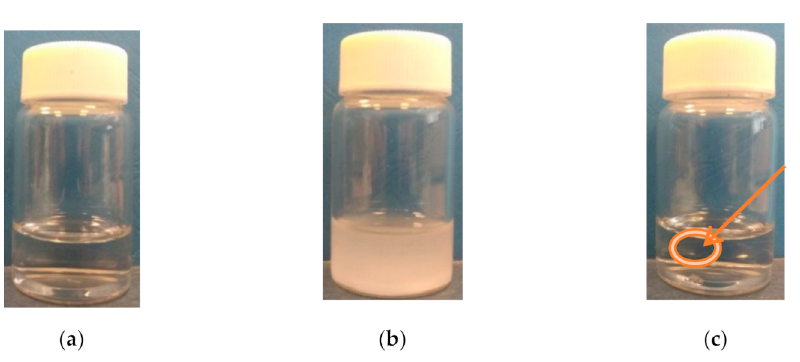
Figure 2. Solution of P(HEMA- co -OEGMA 300 ) in PBS at different temperatures: ( a ) room temperature, ( b ) cloud point temperature ( c ) at 70 ◦ C (the arrow and circle show the formed gel). Concentration of solution: 0.5